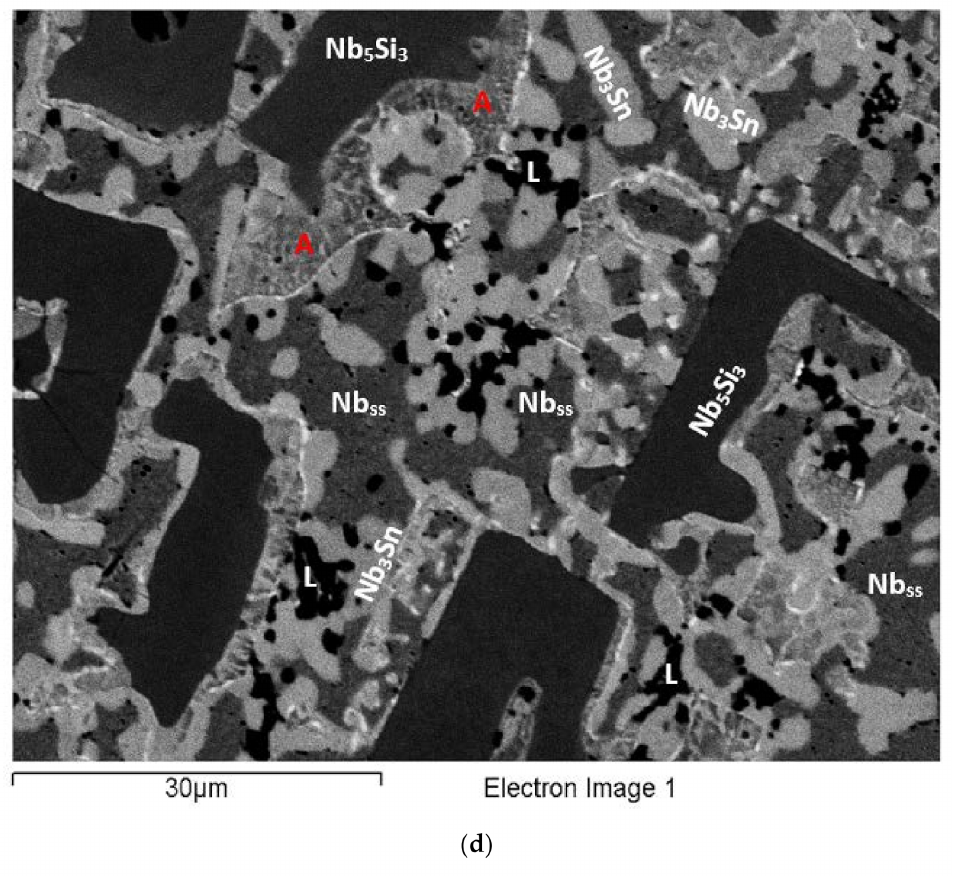
Figure 8. ( a – d ) BSE images of the microstructure of EZ6-HT2. In ( a – d ), the Laves phase is indicated with L. In ( b ), the Hf-rich Nb 5 Si 3 and the A15-Nb 3 X are indicated with the numbers 1 and 2, respectively, while ( c ) shows details of the microstructure near the large Nb 5 Si 3 grain in ( b ). For A in ( b – d ), see text. In ( b – d ), the contrast has been enhanced to show the microstructure